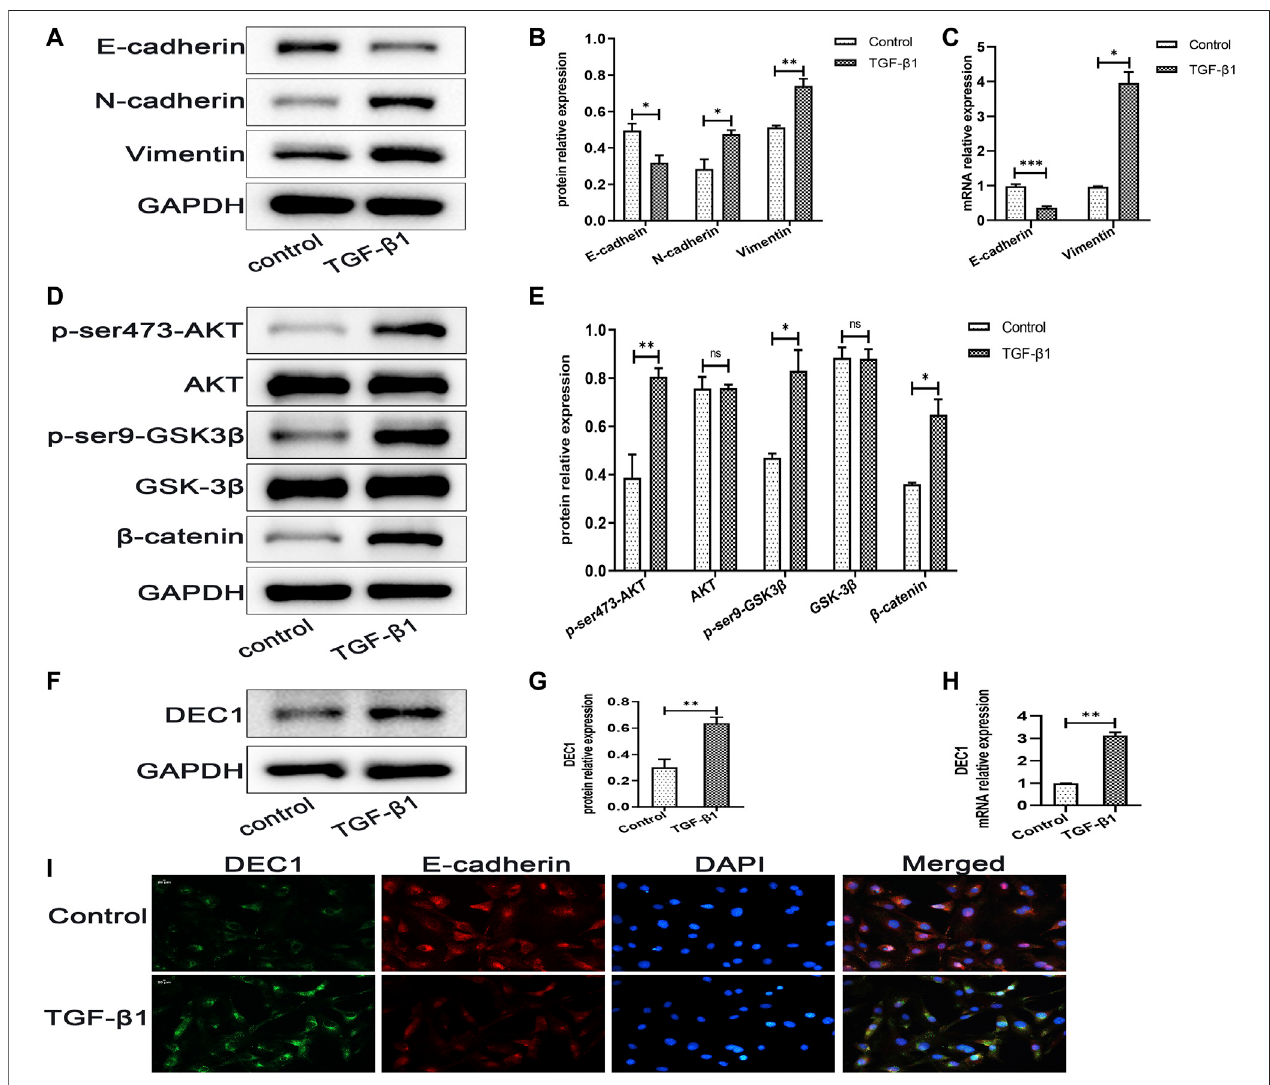
FIGURE 7 | DEC1 expression is upregulated in TGF- β 1-induced EMT in A549 cells. A549 cells were treated with TGF- β 1 for 48 h. (A) The protein expression of E-cadherin,N-cadherinandVimentininA549cellsweremeasuredbywesternblotting. (B) StatisticalanalysisofrelativeexpressionlevelsofproteinsinA. (C) ThemRNA expression of E-cadherin and Vimentin in A549 cells were assessed by qRT-PCR. (D) The protein expression of p-ser473-AKT, AKT, p-ser9-GSK3 β , GSK-3 β and β - catenin in A549 cells were measured by western blotting. (E) Statistical analysis of relative expression levels of proteins in D. (F) The protein expression of DEC1 in A549 cells were detected by western blotting. (G) Statistical analysis of relative expression level of proteins in F. (H) The mRNA expression of DEC1 in A549 cells were detected by qRT-PCR. (I) Dual immuno fl uorescent analysis for DEC1 and E-cadherin expression in A549 cells. Scale bar = 20 μ m n = 3. Data are shown as the mean ± SEM. Statistical analysis was performed by student ’ s t-test. * p < 0.05, ** p < 0.01, *** p < 0.001, ns p > 0.05.